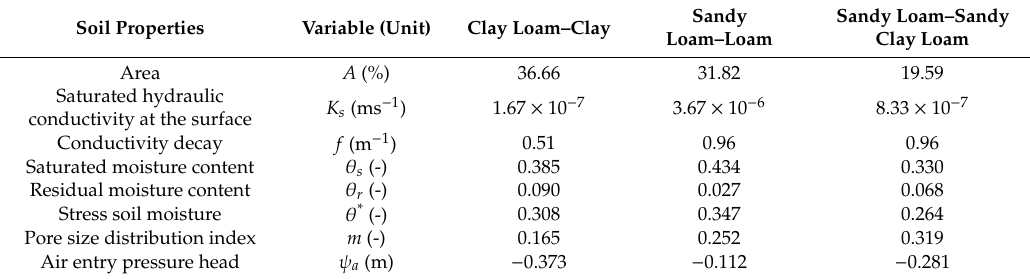
Table 3. Parameters values calibrated for the triangulated irregular network TIN-based Real-time Integrated Basin Simulator (tRIBS) model for the major soil classes of the Rio Mannu basin (RMB) (adapted from Mascaro et al.